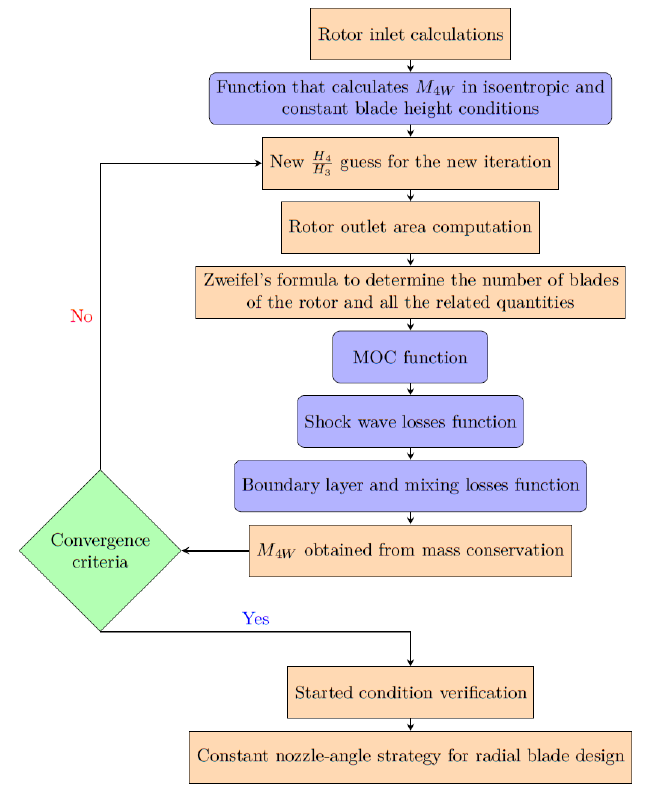
Figure 4. Flowchart to illustrate the iterative process employed to design the rotor in the mean- line